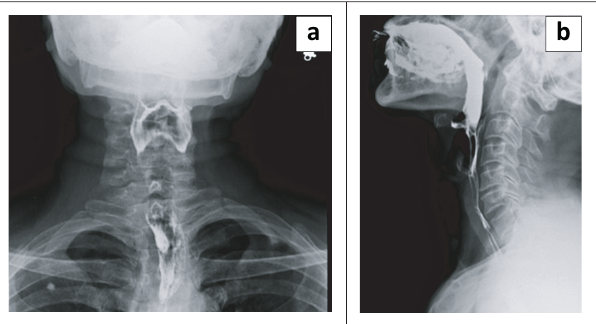
FIGURE 1: (a, b) Barium swallow Antero -posterior (AP) view and lateral view, barium passed down the cervical and upper thoracic oesophagus smoothly and normally.